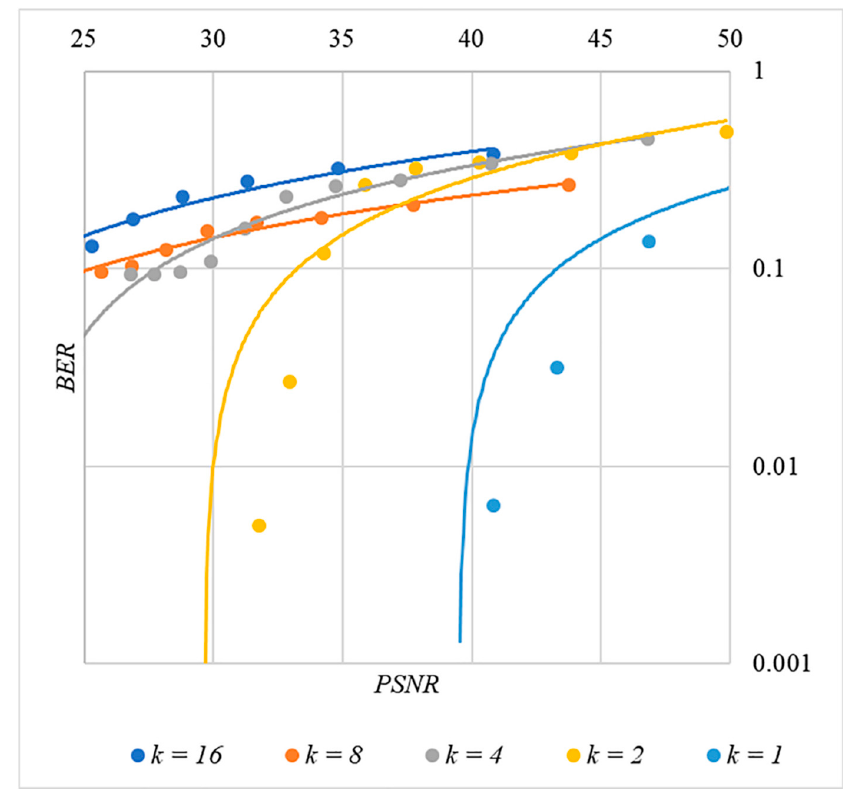
Figure 14. BER ( PSNR ) dependencies for different values k rule for generating chip codes № 2.